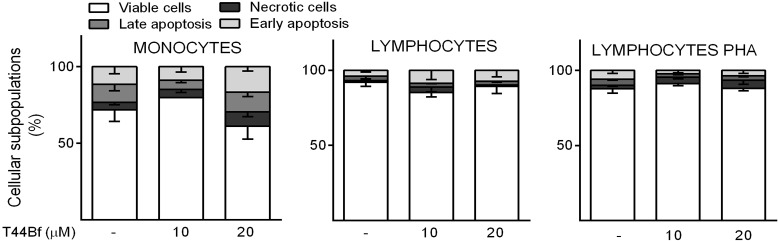
Compound selectivity assessed in normal peripheral blood mononuclear cells (PBMC).Phosphatidylserine exposure was measured by annexin V binding assay in monocytes, unstimulated lymphocytes or Phytohemagglutinin A activated (i.e. proliferating) lymphocytes after 24h treatment with T44Bf at the indicated concentrations or to 0.05% (v/v) DMSO vehicle control group. Data represent the mean ± SD (n > 3). *P<0.05.